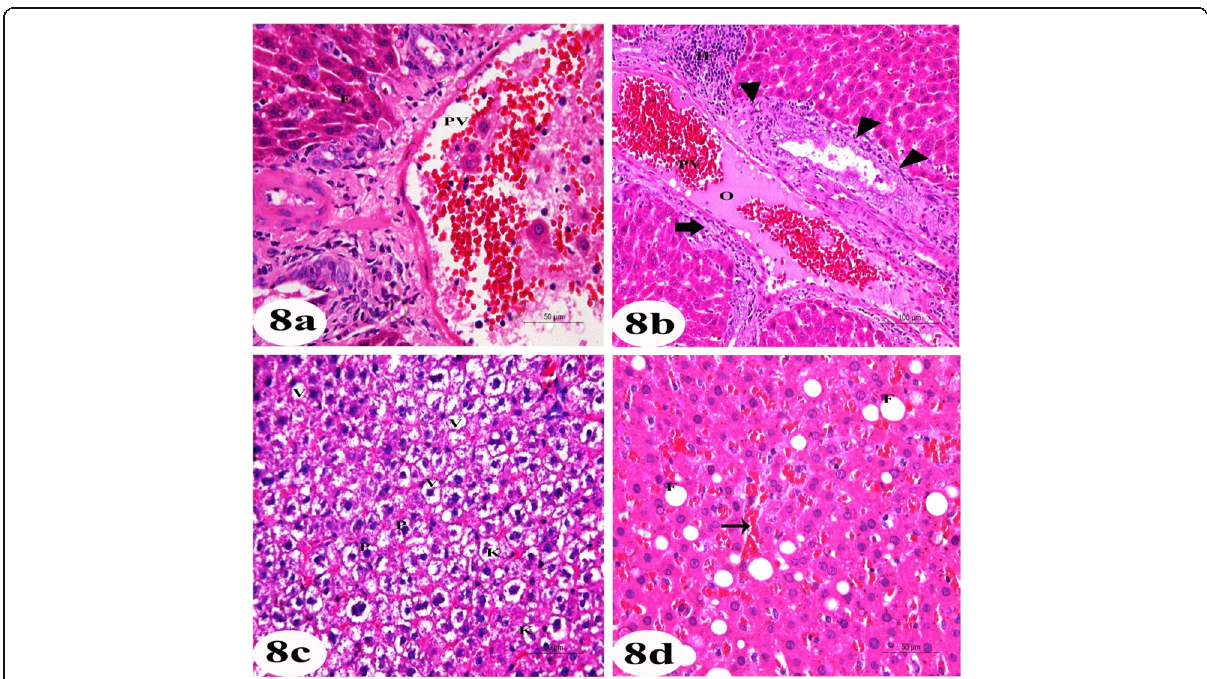
Fig. 8 Photomicrographs of sections of liver of LCT-treated rats for 60 days stained with H&E. a , b Showing mononuclear leukocytic infiltration (IF), congested portal vein (PV) with thickened wall (thick arrow), edema (O), eosinophilic hepatocytes (E), and proliferation of bile duct, where some of them with hyperplastic wall (arrow head) (scale bar = 50 and 100 μ m respectively). c , d Showing extensive vacuolar degeneration (V) of hepatocytes, dilated hyperemic sinusoids (thin arrow), and many hepatocytes with pyknotic (P) and karyolytic (K) nuclei, fatty changes (F) (scale bar = 50 μ